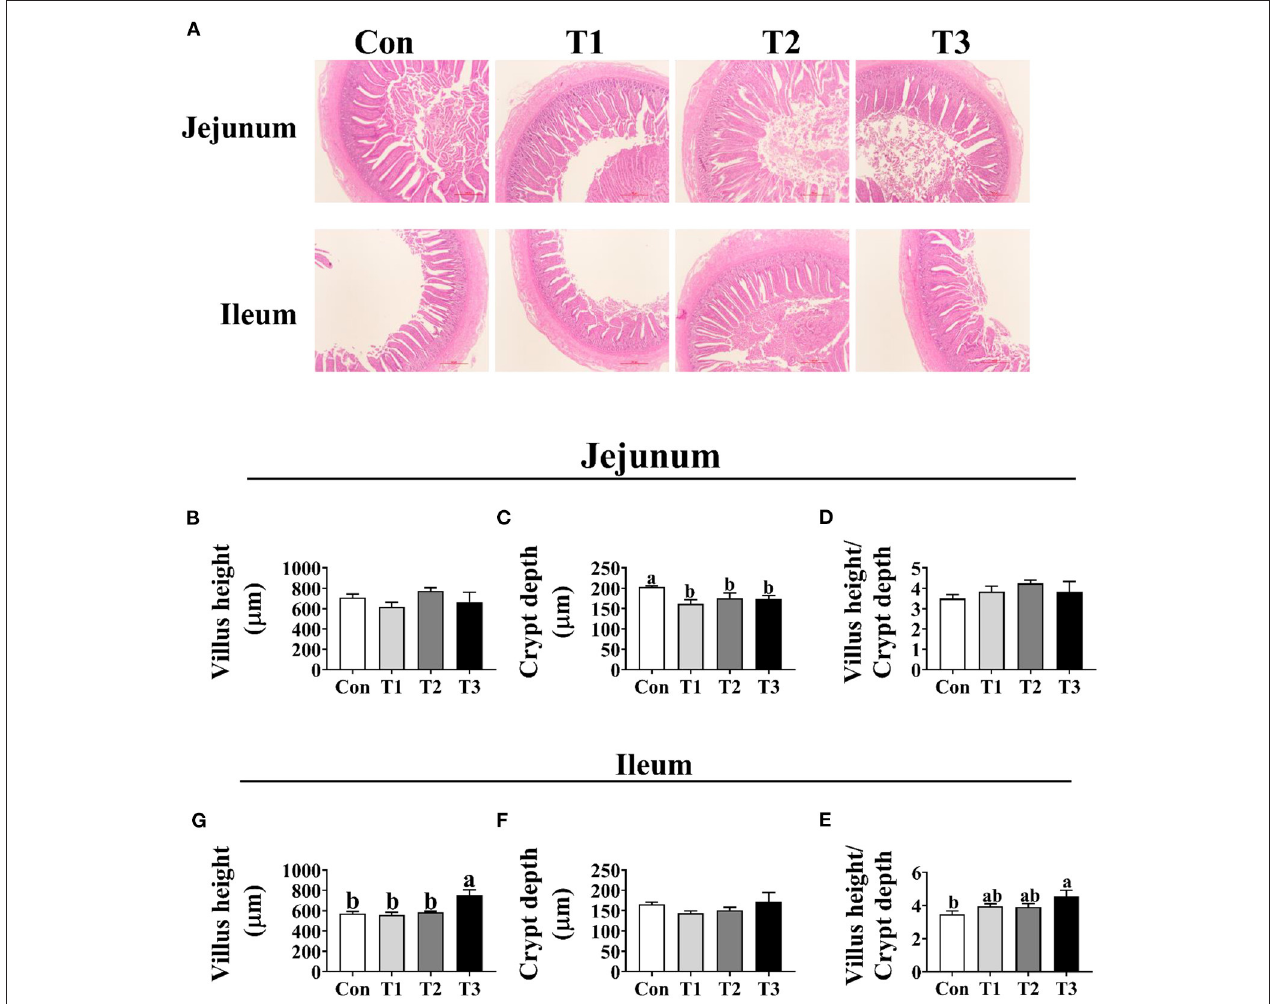
FIGURE 3 | Effects of dietary supplementation with Elephantopus scaber on intestinal morphology of duck. (A) The images of the jejunum and ileum morphology; bar = 500 µ m. Summarized date of villus height, crypt depth, and the ratio of villus height to crypt depth in jejunum (B–D) and ileum (E–G) .